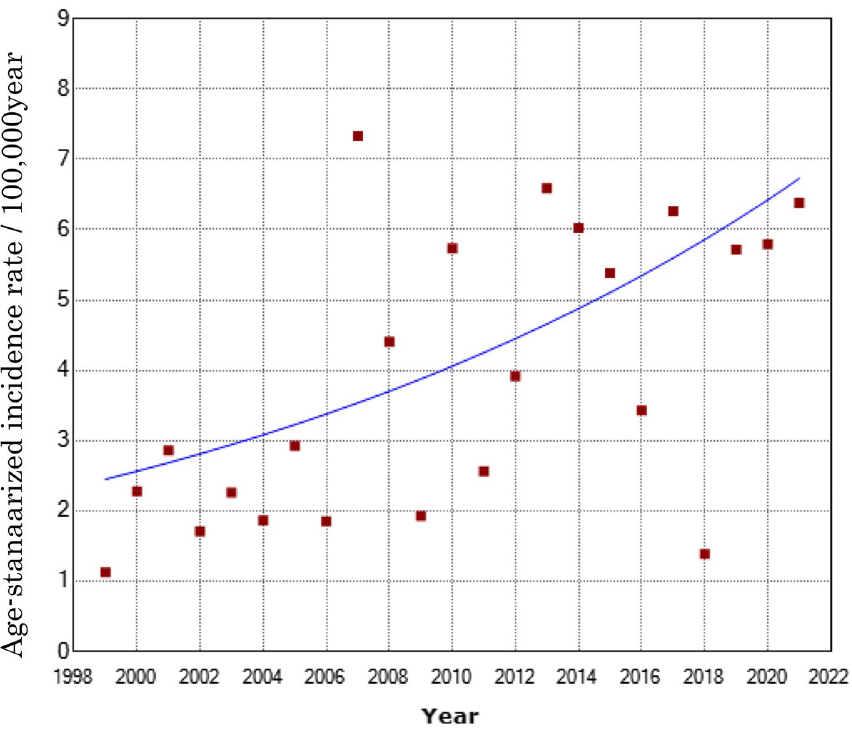
Figure 1. Annual trend of the age-standardized incidence rate of Type 1 Diabetes (T1D) aged 0-14 years during 1999–2021. The incidence of type 1 diabetes in those aged ≤ 14 years increased annually by 4.7% (P = 0.004; 95% CI [1.7, 7.8]).